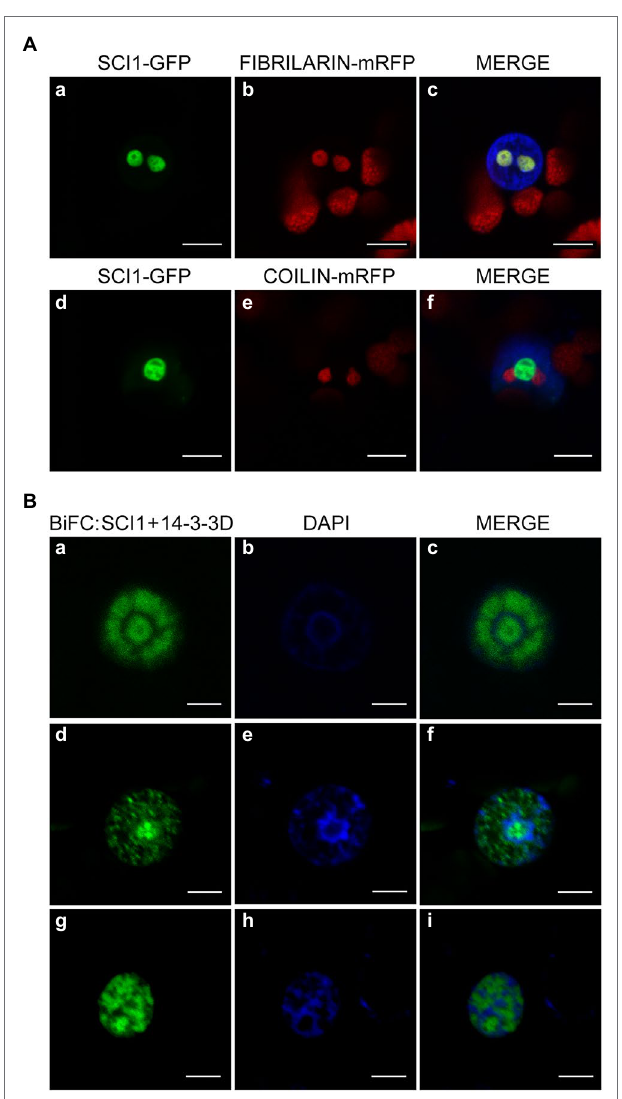
FIGURE 3 | (A) Co-localization of SCI1-GFP with the nuclear markers AtFibrillarin-mRFP for nucleoli and AtCoilin-mRFP for Cajal bodies (Koroleva et al., 2009), in transiently transformed N. benthamiana leaf cells. The red color organelles observed outside of the nucleus correspond to chloroplasts (auto-fluorescence). (B) BiFC assays indicating that SCI1 interacts in vivo with 14-3-3D protein in the nucleus of epidermal cells of N. benthamiana leaves. This interaction was observed only in cells at G2/prophase (early mitosis). Three different cells are shown in each line (Ba,d,g) . Blue indicates DAPI stained DNA. Green indicates the interaction of SCI1-nGFP and 14-3-3D-cGFP (a–i) . nGFP, N-terminal fragment of GFP (amino-acid residues 1–149); cGFP, C-terminal GFP fragment (amino-acid residues 150–238). Scale bars—5 μ m.